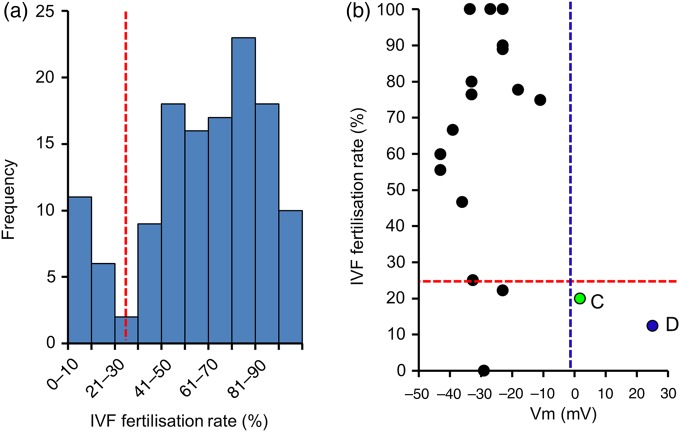
Highly depolarized membrane potential is associated with poor fertilization rate in IVF. (a) The distribution of fertilization rates (% fertilized) for 126 IVF patients. Two separate groups can be identified (separated by dashed red line). Most patients achieved ≥25% fertilization but a ‘poor’ subgroup, with fertilization rate <25% is also present. (b) The relationship between mean membrane potential and fertilization rate for 19 patients for whom multiple recordings and fertilization rate data were obtained. (Patients C and D are labelled.) Dashed lines delineate categories used for χ2 contingency analysis: red line shows poor and normal fertilization groups (<25 and ≥25%); blue line shows ‘normal’ Vm and highly depolarized (<0 and ≥0 mV). P = 0.012.